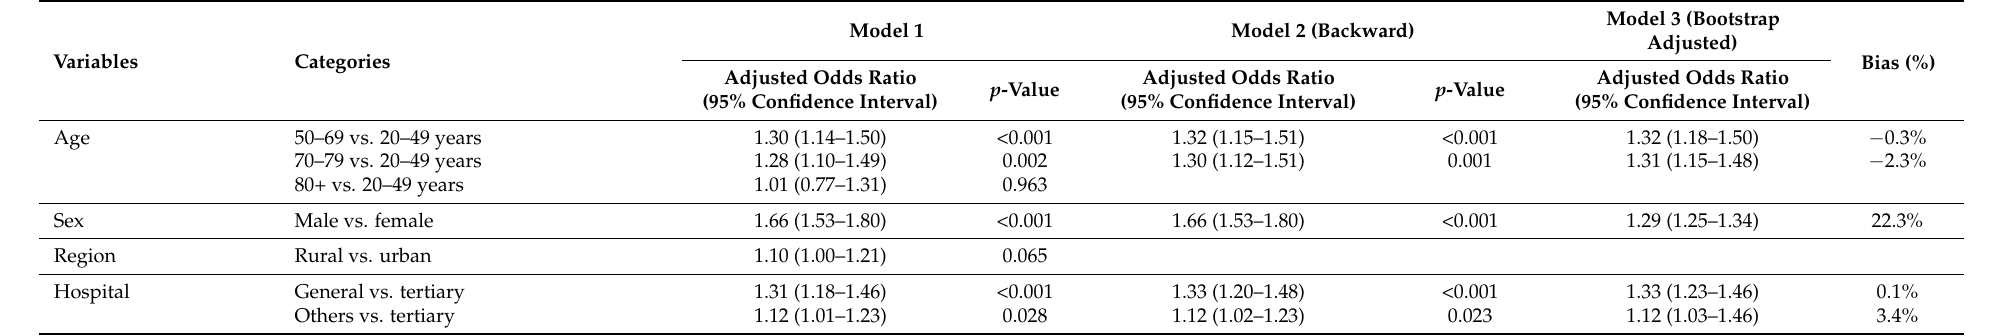
Table 5. Risk factors for reoperation within 3 years after instrumented spinal fusion surgery for degenerative spinal disease: multivariable